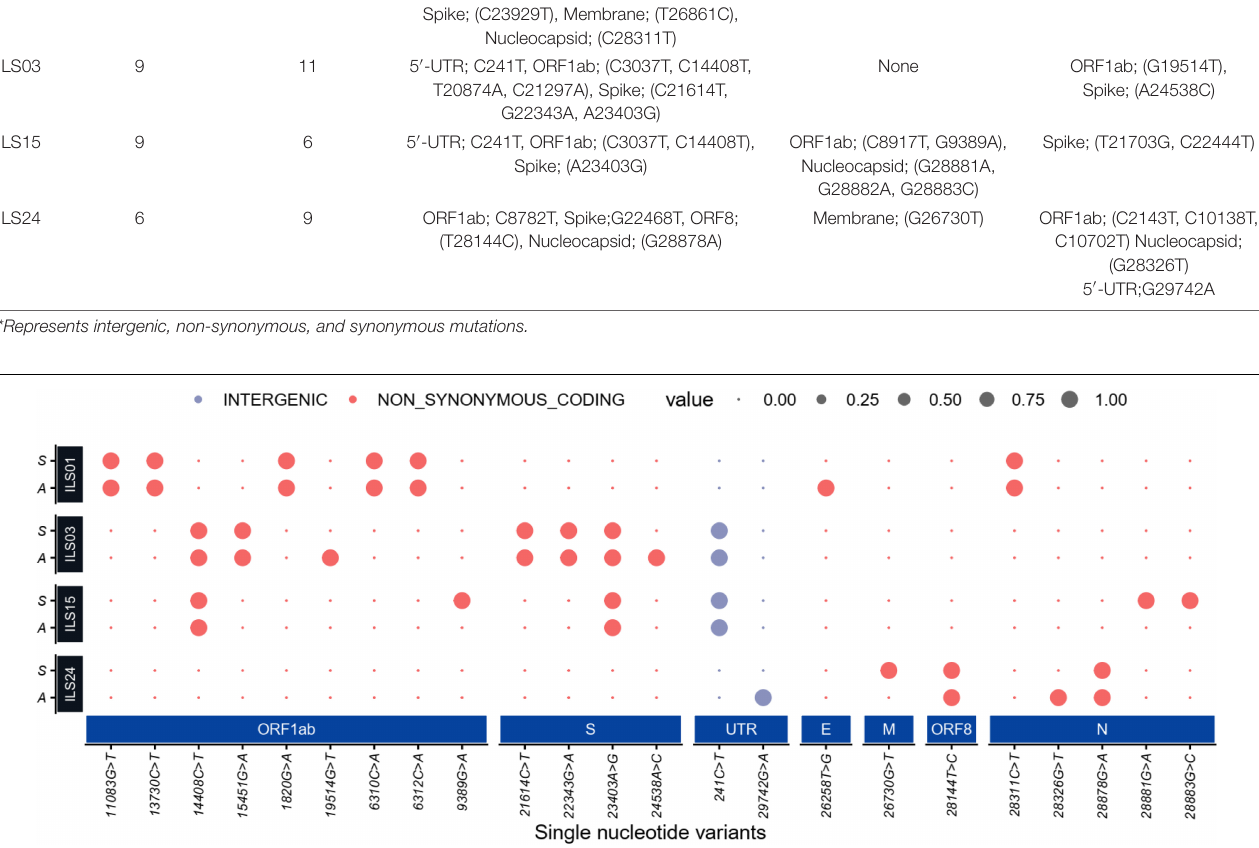
Frontiers in Microbiology |